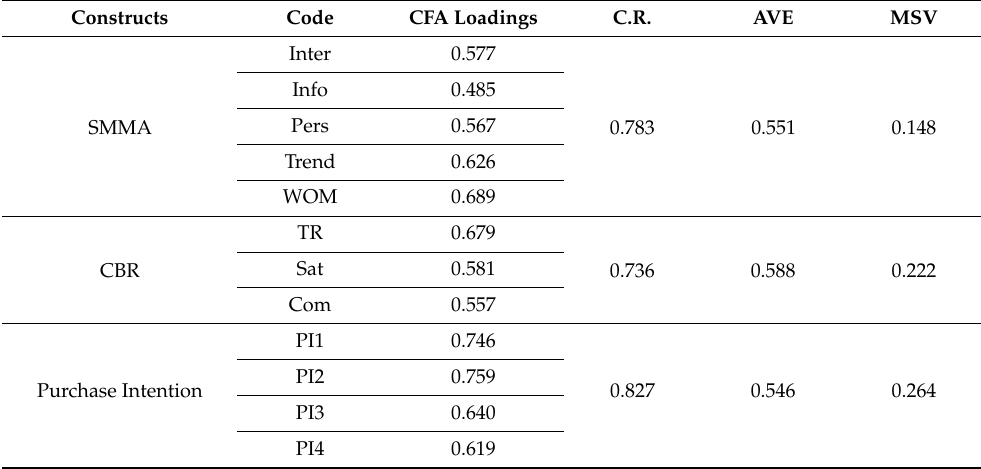
Table 4. Loadings of CFA Second